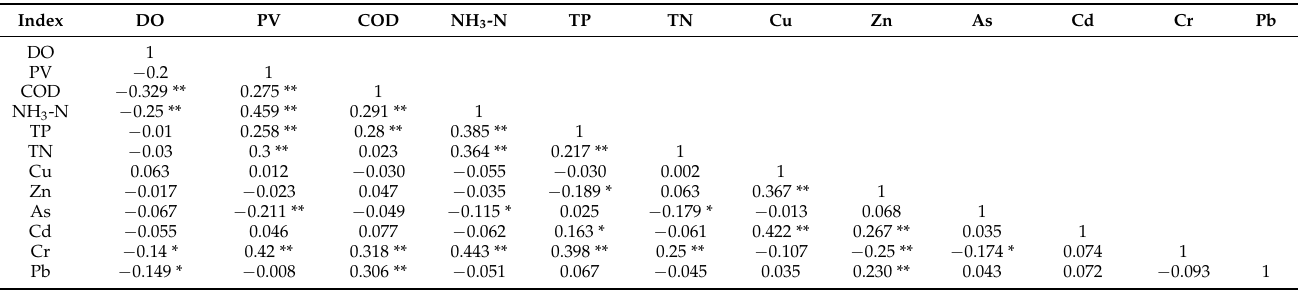
Table 7. Results of correlation analysis between water quality indicators.